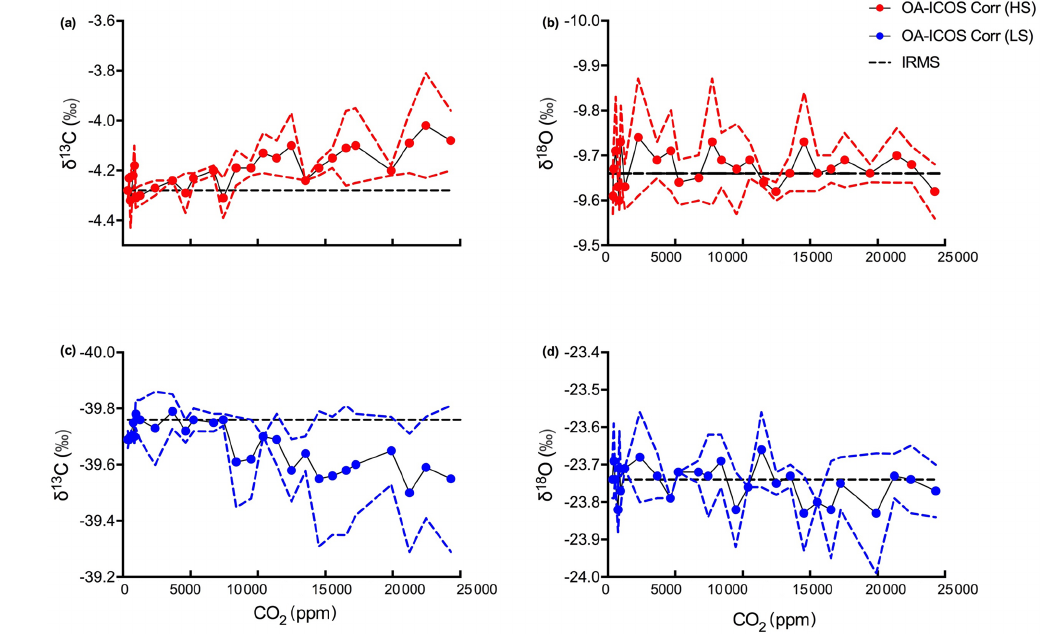
Figure 6. Corrected (a, c) δ 13 C and (b, d) δ 18 O measurements by OA-ICOS CO 2 carbon isotope analyser. δ 13 C and δ 18 O measured for heavy standard and light standard are shown as red and blue circles respectively. Actual δ 13 C and δ 18 O values reported after measuring by IRMS are shown as black dashed lines, and 95% confidence intervals are shown as coloured dashed lines,